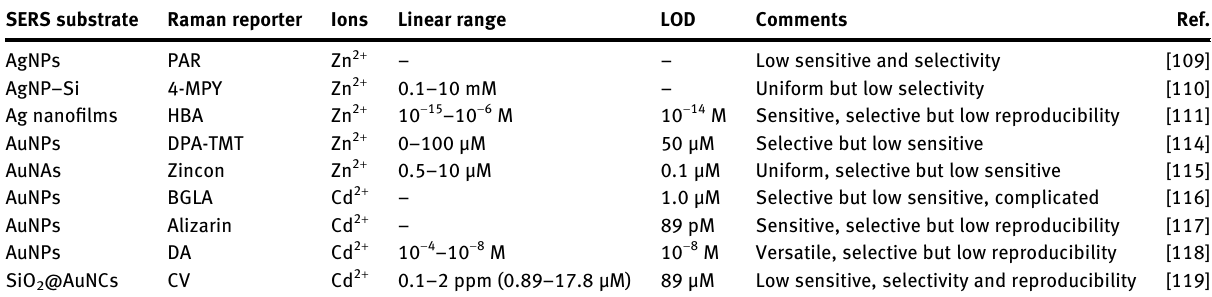
Table  : The methods of detection of Zn  + and Cd  + ions based on the SERS technique. SERS